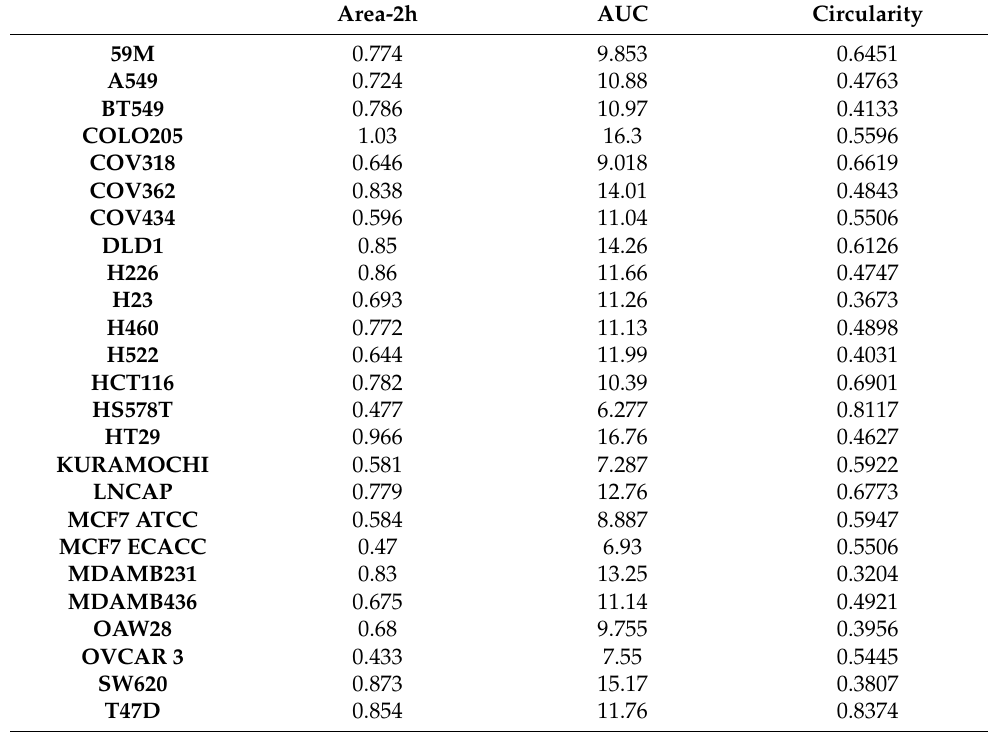
Table 1. Summary of the three aggregation parameters (area-2h, AUC, and circularity) extracted from the aggregation curves of the 25 cancer cell lines under study. Values are the mean of 25 to 48 replicates from three to five independent experiments. Area-2h AUC Circularity